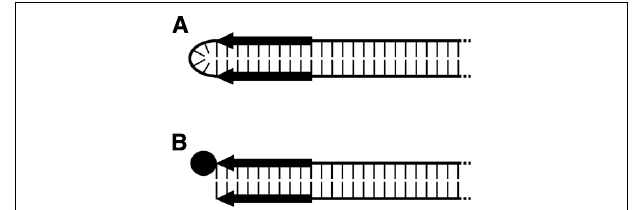
FIGURE 2 | Schematic representation of the termini of the two types of linear plasmids. (A) Hairpin plasmid. (B) Linear plasmid with 5 ′ -attached terminal protein (TP). Black arrows indicate the terminal inverted repeats (TIRs), and the TP is depicted as a filled